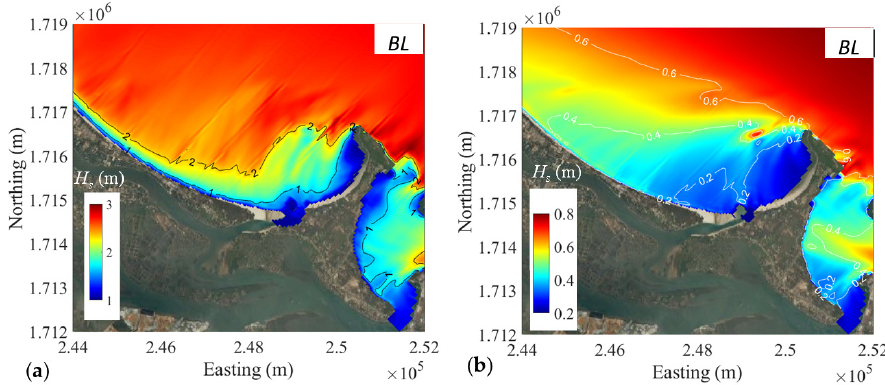
Figure 12. Wave height during ( a ) Northeast monsoon and ( b ) Southeast monsoon under current conditions.